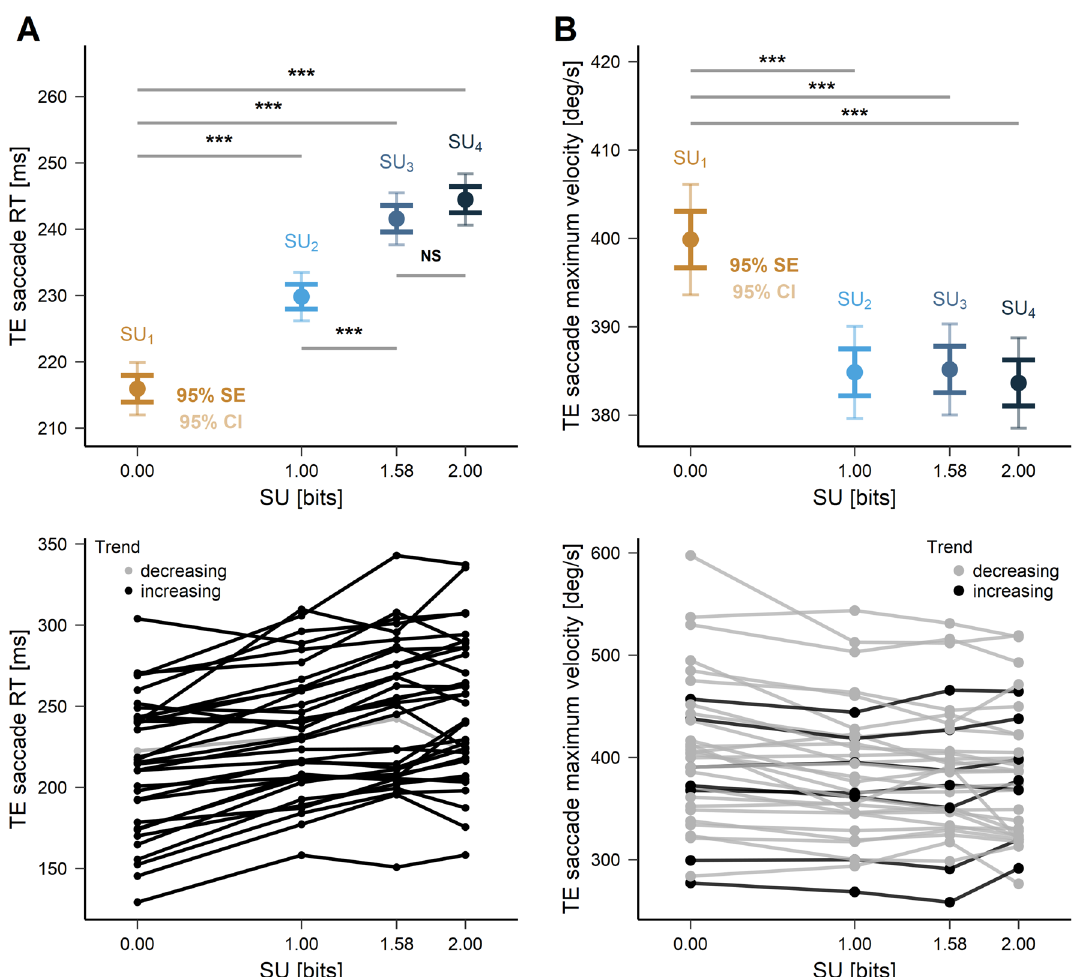
Figure 5. ( A ) Mean visually-guided RT (dots) for each SU context with standard error and confidence interval whiskers (upper panel) and divided by subject (bottom panel). Horizontal grey lines indicate LMM significance between conditions. Black lines show individuals with the decreasing trend. Different SU contexts are expressed in bits. ( B ) Mean visually-guided maximum velocity (dots) for each SU context with standard error and confidence interval whiskers (upper panel) and divided by subject (bottom panel). Horizontal grey lines indicate LMM significance between conditions. Black lines show individuals with the decreasing trend. Different SU contexts are expressed in bits. The trend was calculated as the difference between SU 1 and SU 4 conditions.